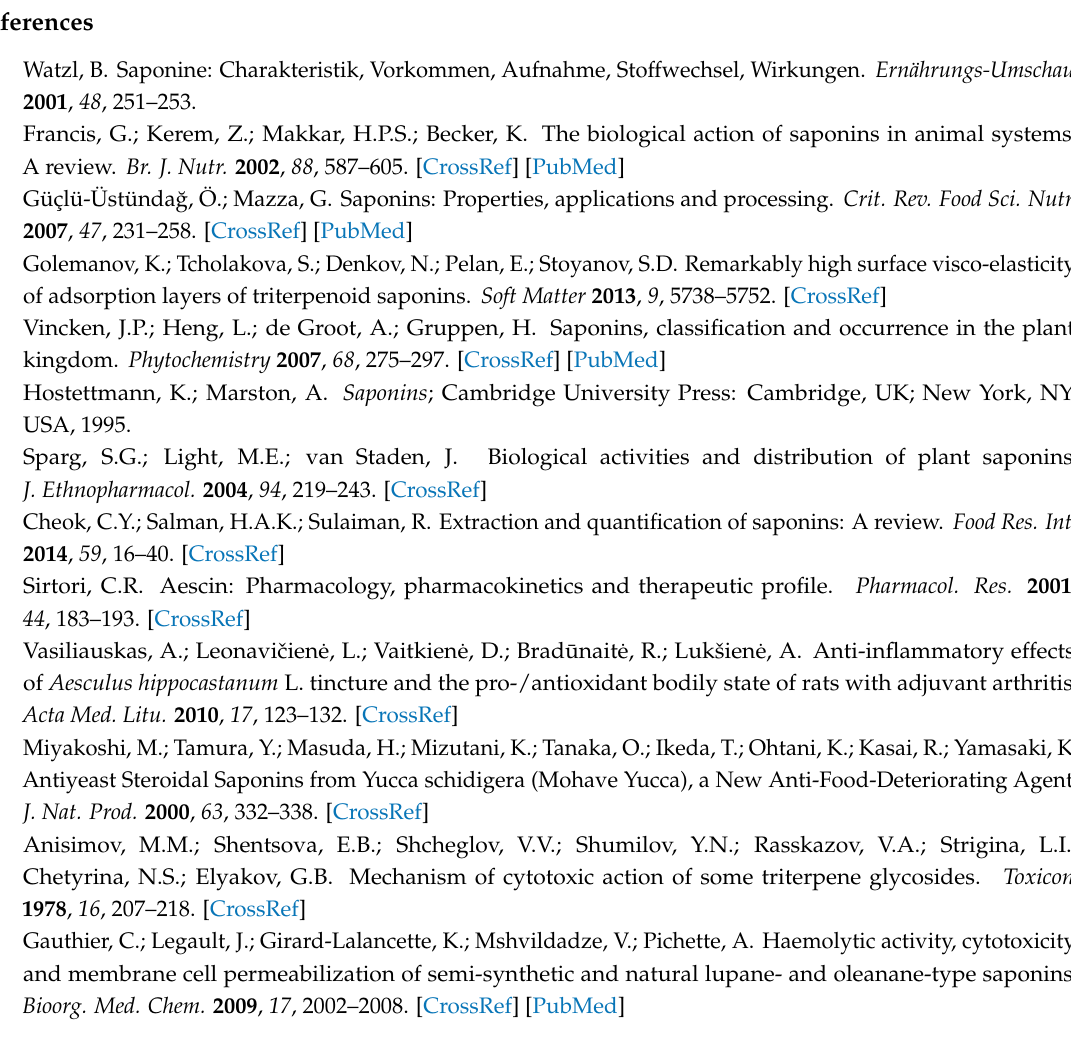
Figure S1: LC-MS run of aescin fractions 1 and 2, Figure S2: Mass spectra of aescin fractions belonging to LC-MS run, Figure S3: 1 H-NMR spectra of aescin fractions, Figure S4: Assignment of protons in the aescin structure to 1 H-NMR signals, Figure S5: Titration curve of aescin in aqueous solution, Figure S6: Concentration-normalized autofluorescence of aescin, Figure S7: Surface tension isotherm obtained by the Du Noüy ring method, Figure S8: Time-dependent SFT measurement at constant aescin concentration, Table S1: List of 1 H-NMR